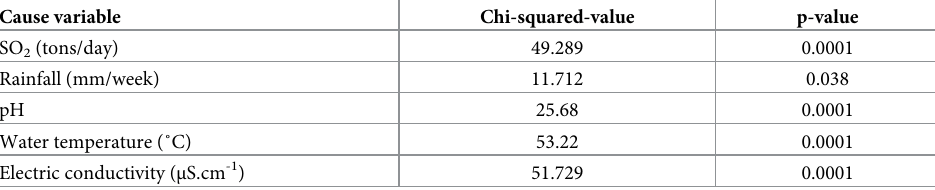
Table 6. Instantaneous causality tests for number of cholera cases and environmental variables (rainfall. water temperature. water electric conductivity. water Ph. volcanic sulphur dioxide emission) for 2007–2012 period. Katana Health Zone. DR Congo (n = 147 sampled